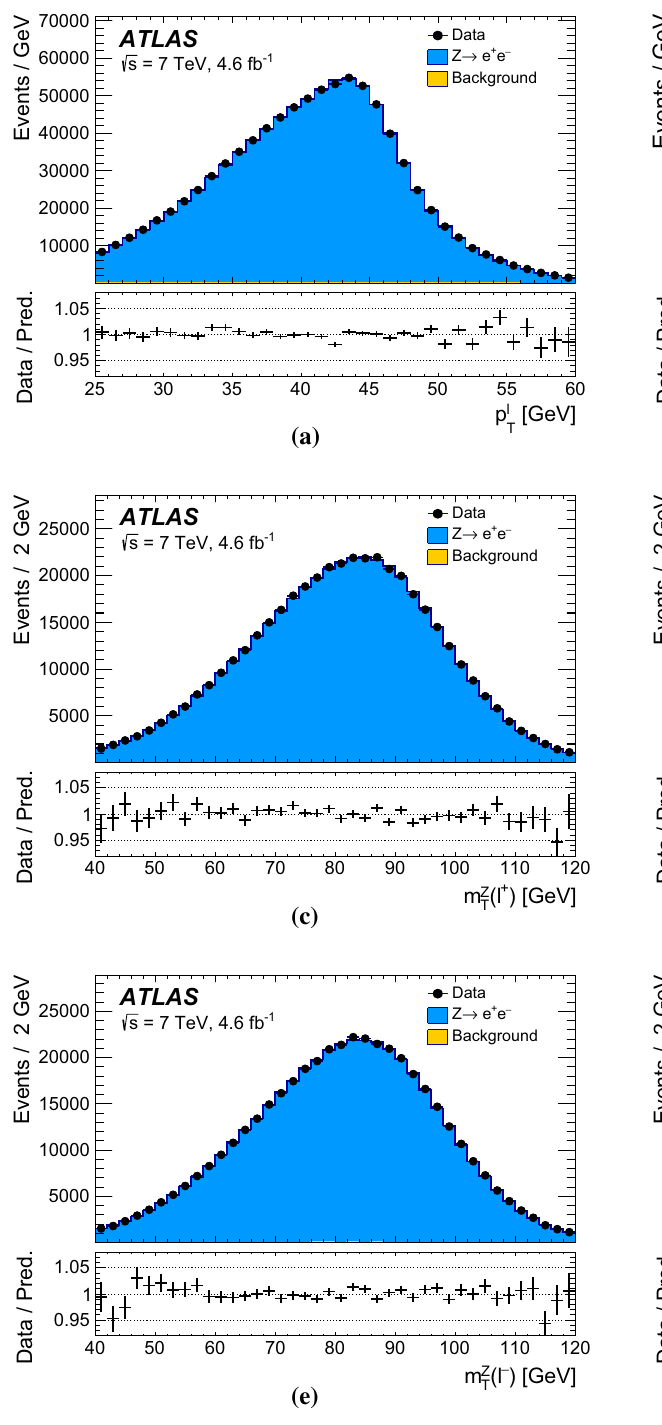
Fig. 15 The p (cid:7) distributioninthe a electronand b muonchannels,and T m T distributions in the c , e electron and d , f muon decay channels for Z eventswhenthe c , d negativelycharged,or e , f positivelychargedlepton is removed. The data are compared to the simulation including signal and backgrounds. Detector calibration and physics-modelling correc-